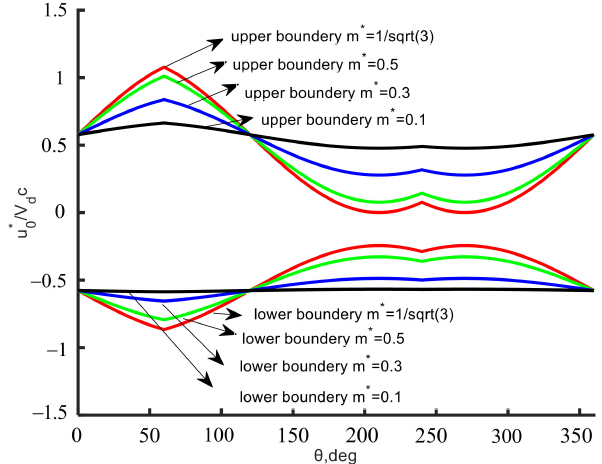
Figure 8. Available modulation range for u ∗